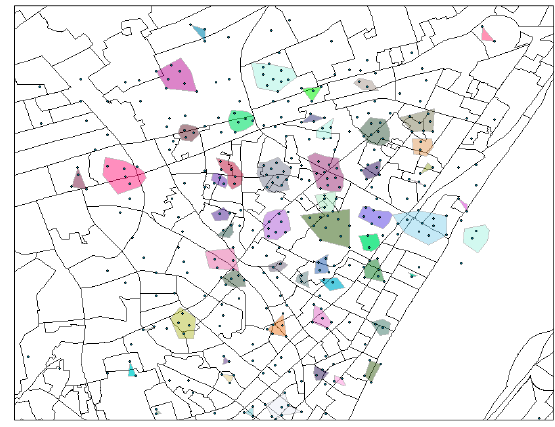
Figure 2. Local clustered points.